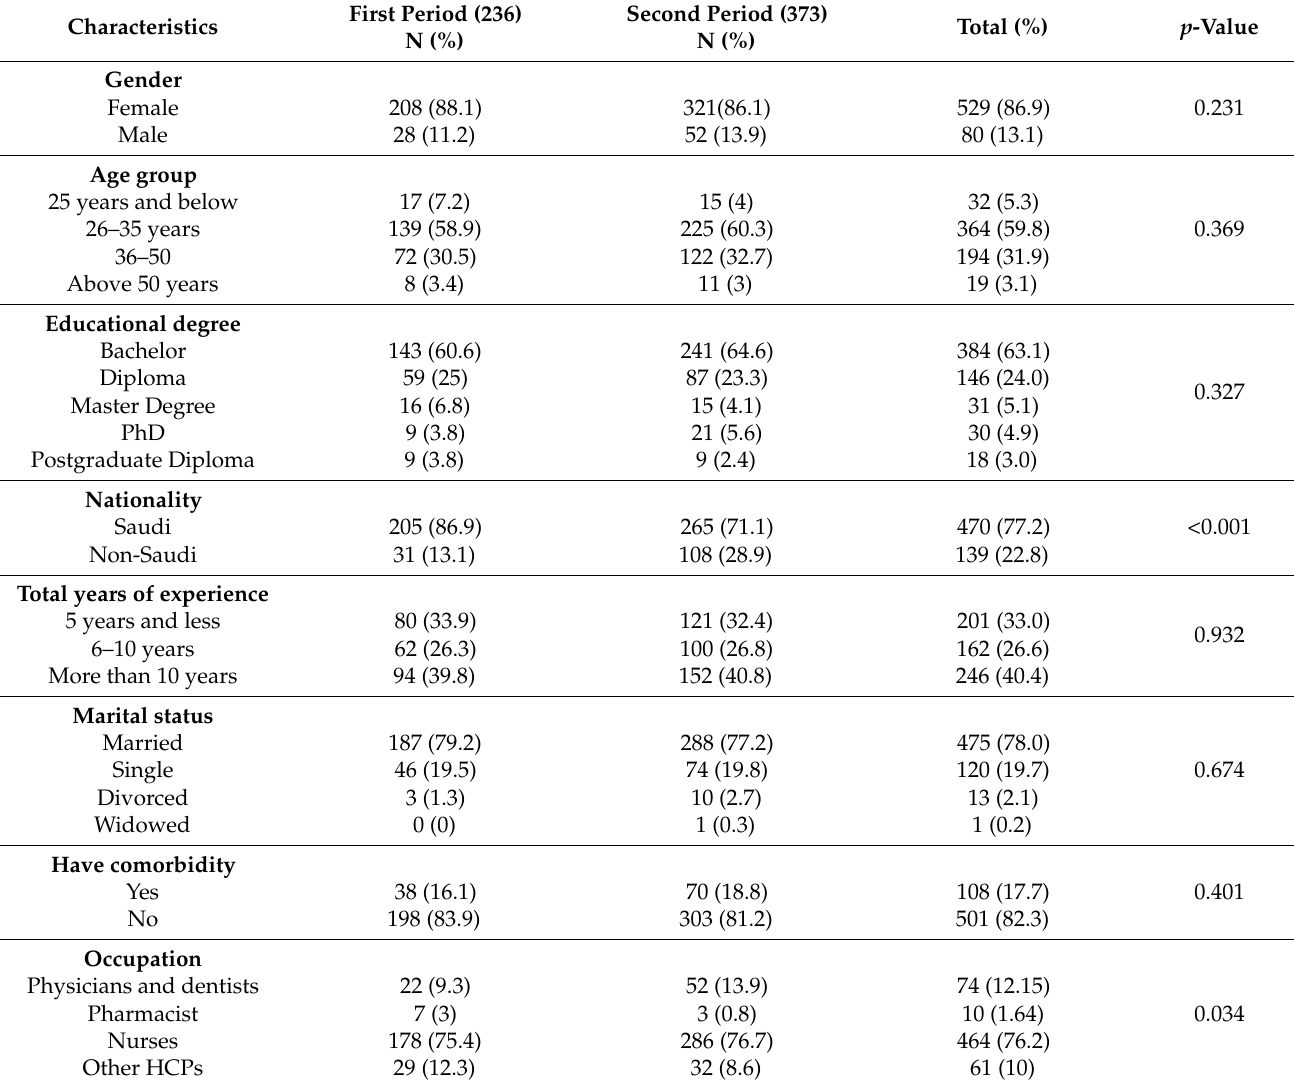
Table 1. Basic socio-demographic characteristics of participants (n =